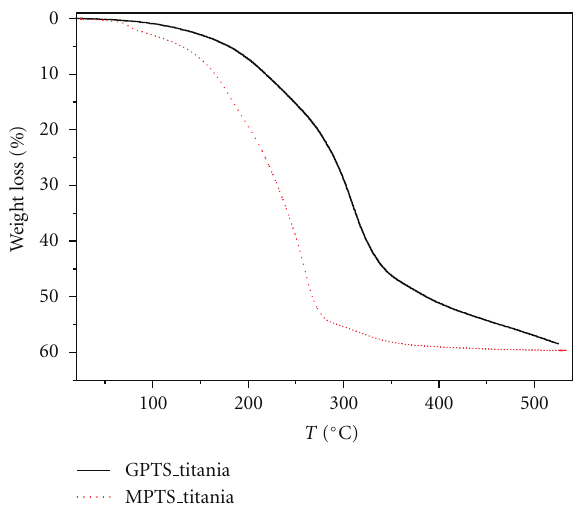
one (b) treated with UV curing and further 2